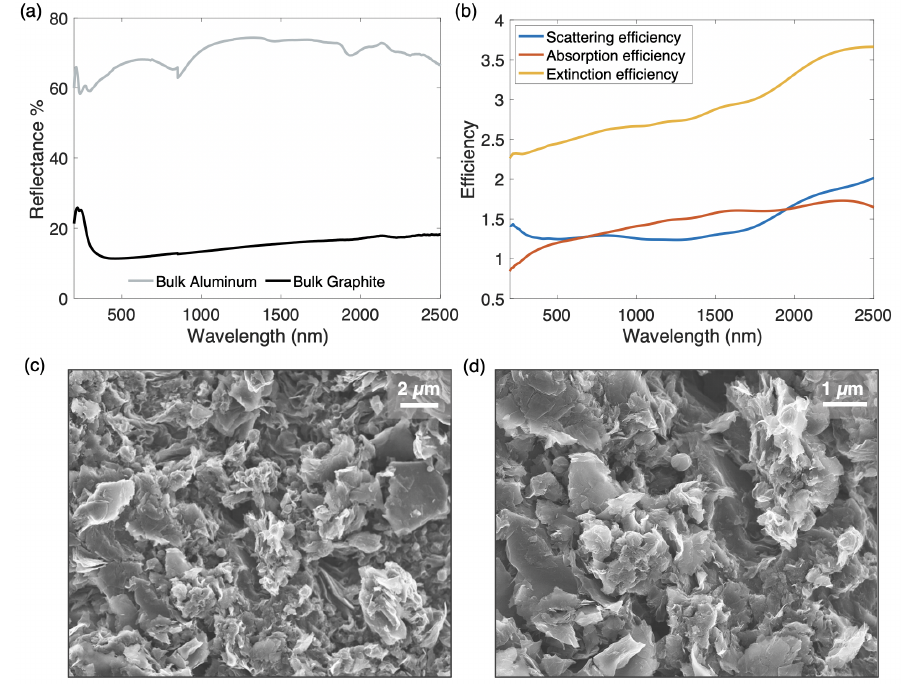
Figure 2. ( a ) Reflectance spectra of bulk materials used within the tunable piston structure. ( b ) Scat- tering, absorption, and extinction efficiencies of graphite. SEM images of graphite surface at magnifi- cations of ( c ) 4000 and ( d ) 10,000. The SEM images are used to estimate an average graphite particle size of 660